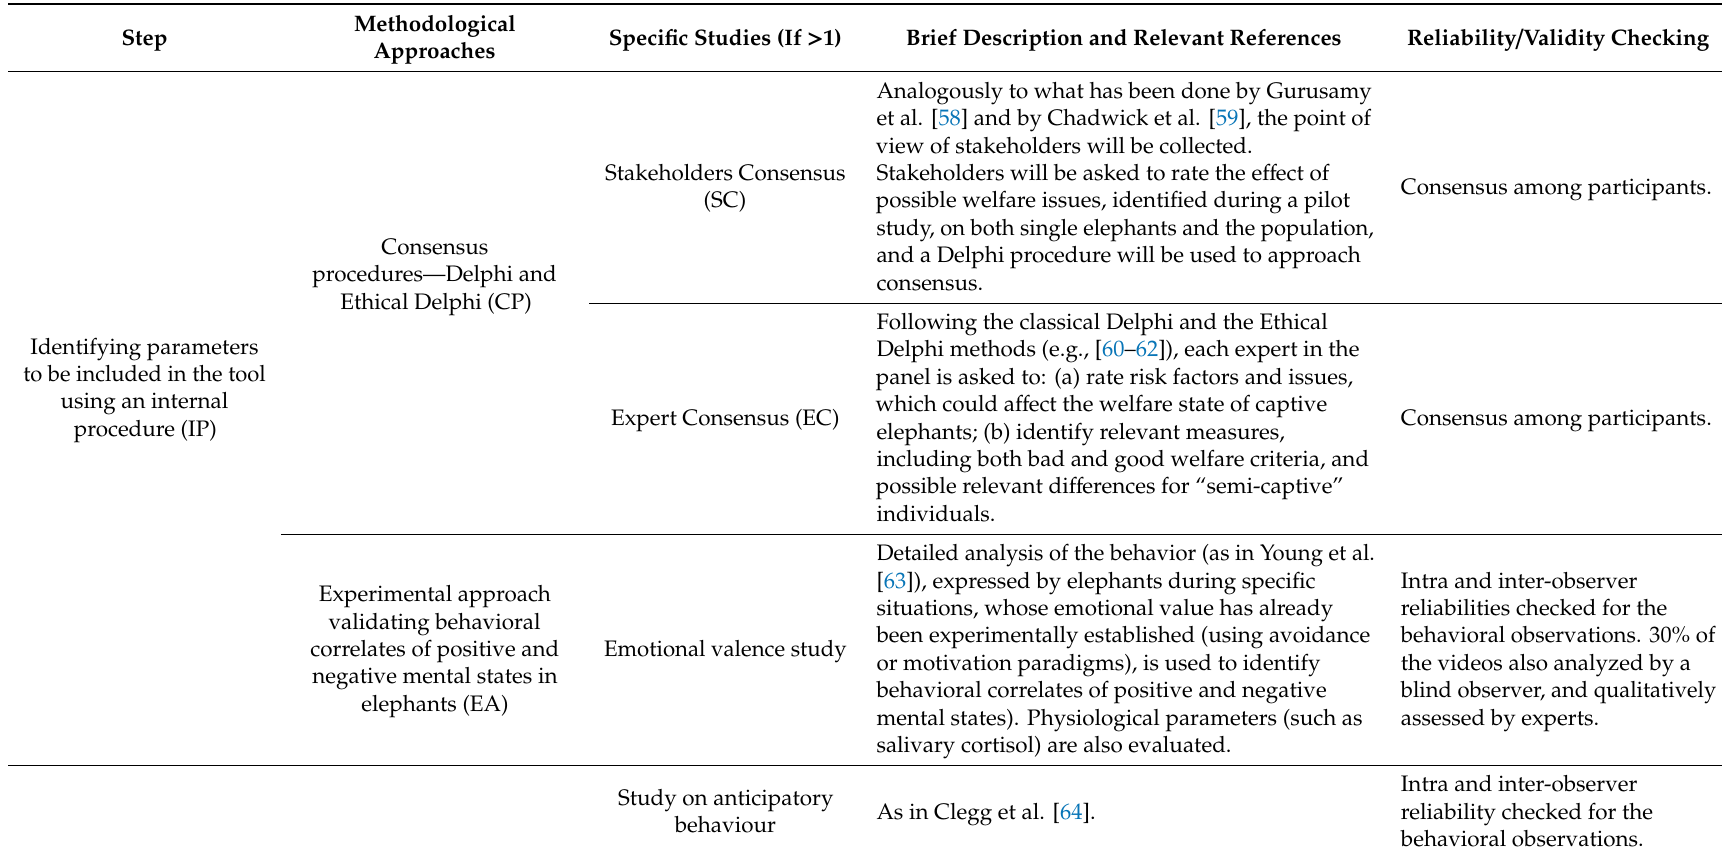
Table A1. Summary of the main methods and steps included in the project for the housing and management protocol